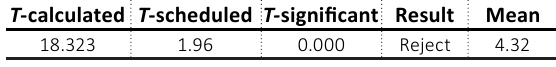
Table 13. Results of the fourth sub-hypothesis